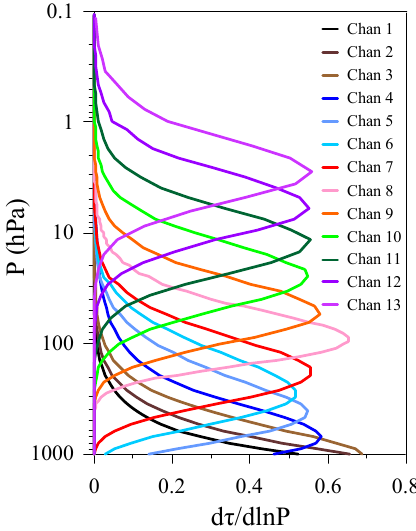
Figure 1. Weighting functions of FY-3C MWTS-2 calculated using US standard atmosphere